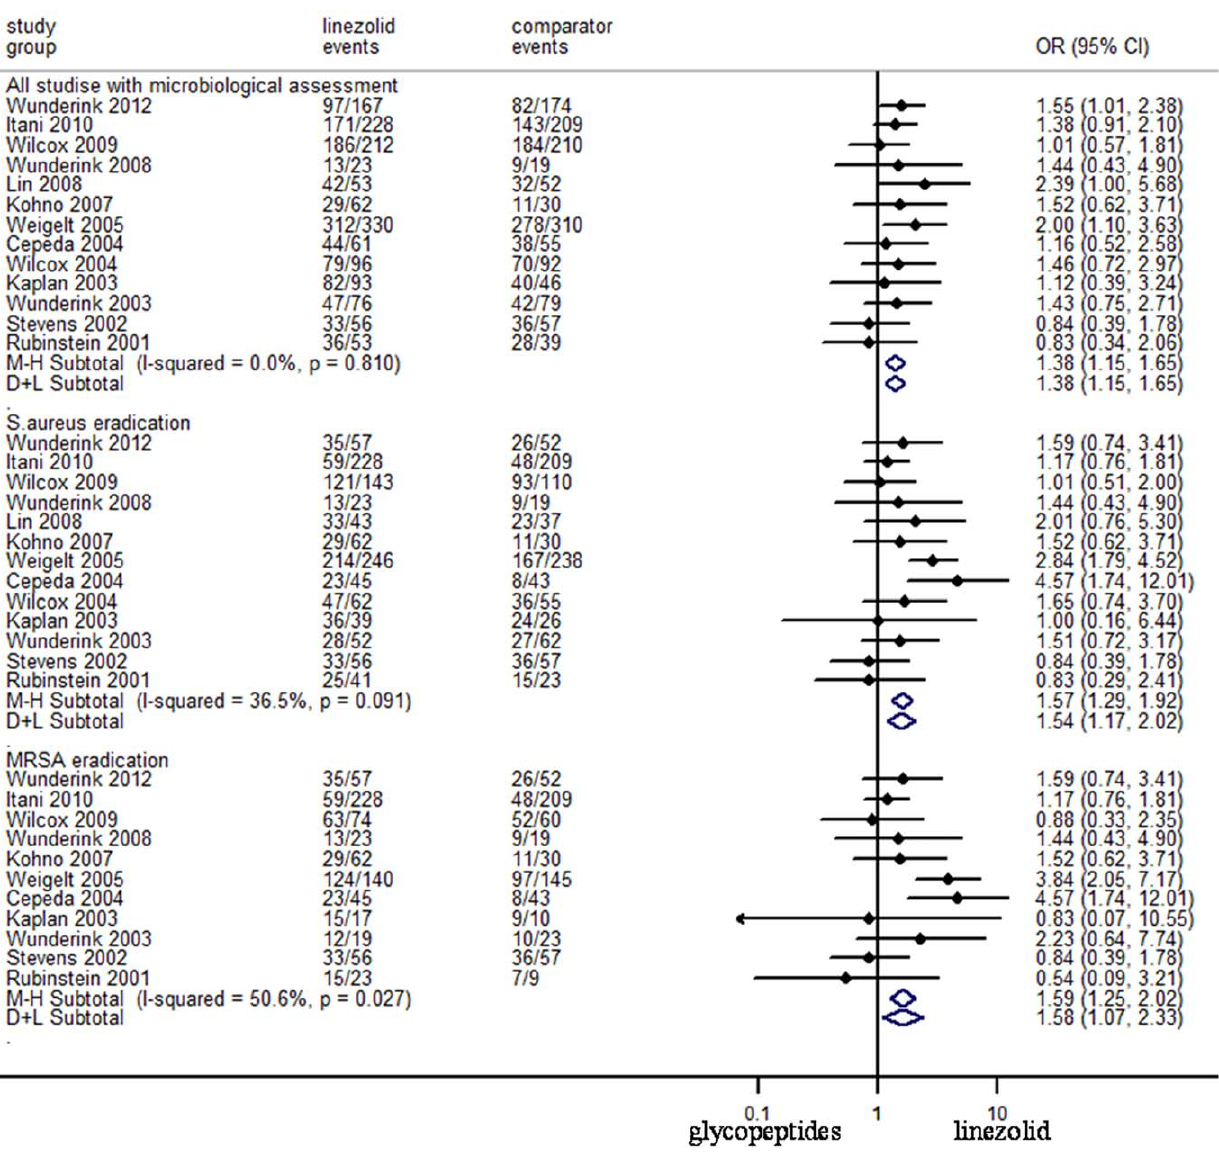
Figure 4. Meta-analyses of treatment success for microbiologically assessed patients. Test of all studies with microbiological assessment for overall effect: Z=3.46 P =0.001; test of S.aureus eradication for overall effect: Z=4.43 P =0.000; test of MRSA eradication for overall effect: Z=3.78 P =0.000.